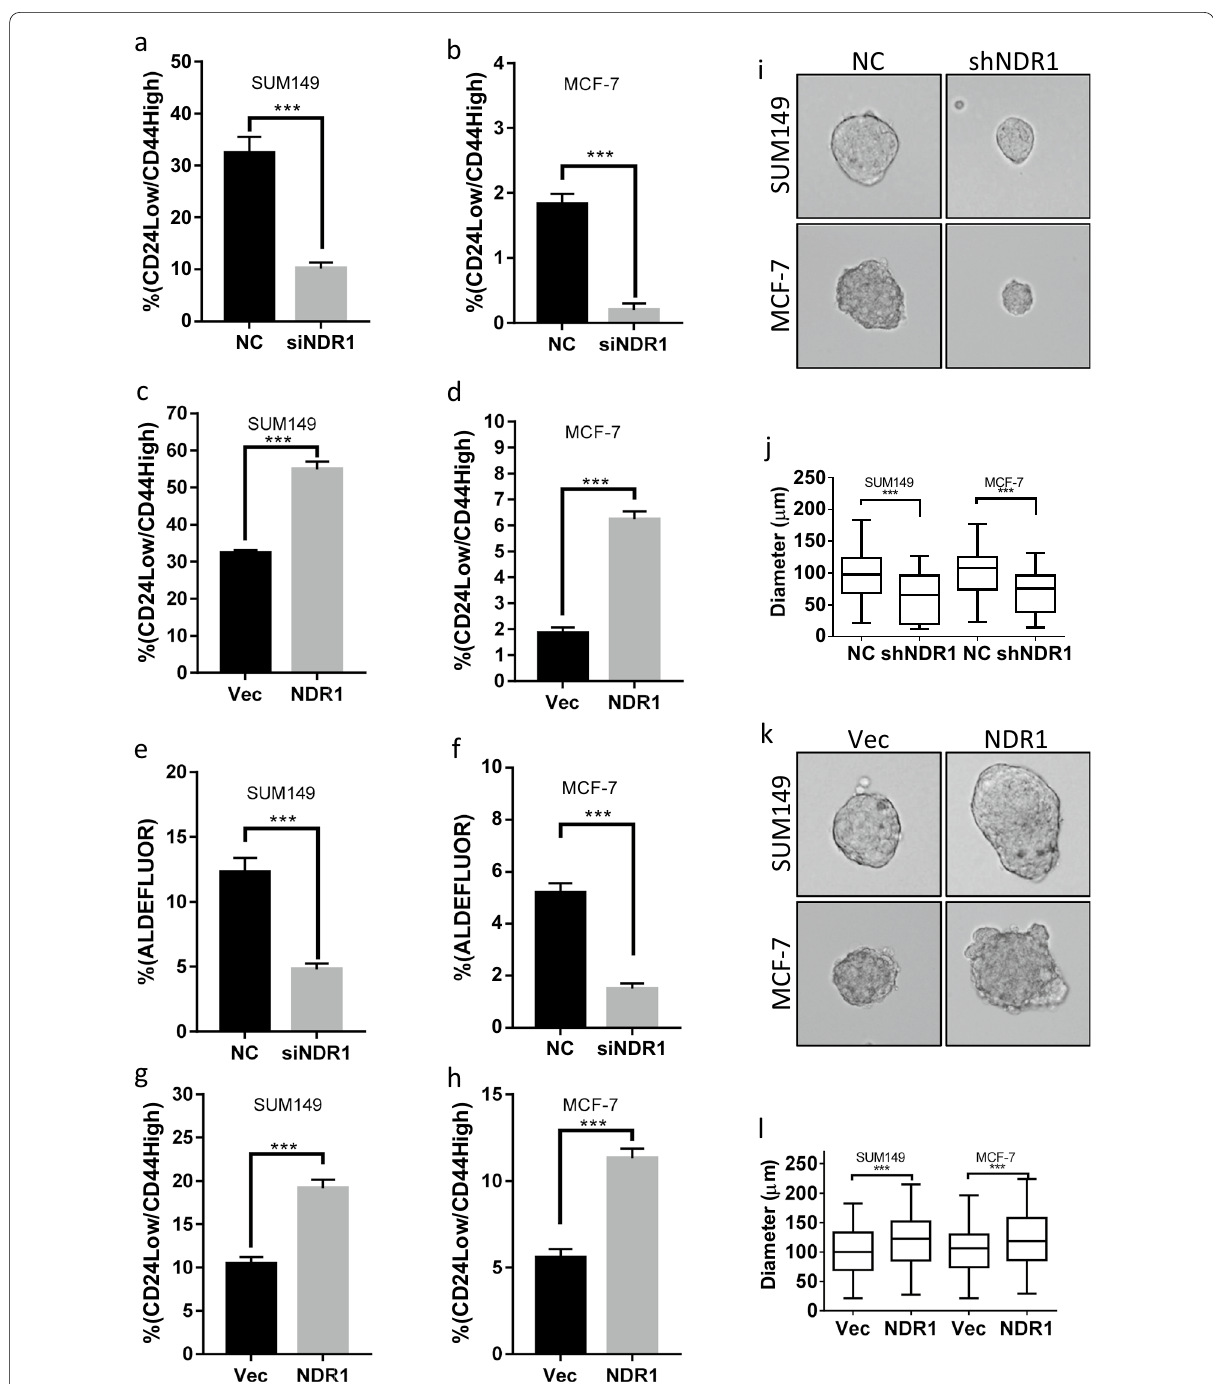
Fig. 2 NDR1 is critical for the regulation of cancer stem cell properties in breast cancer cells. a , b NDR1 siRNA or control siRNA were transfected in SUM149 or MCF‑7 cells for 72 h. Cells were harvested and subjected to CD24/44 staining and flow cytometry analysis. c , d NDR1 or control vector were expressed in SUM149 or MCF‑7 cells for 72 h. Cells were harvested and subjected to CD24/44 staining and flow cytometry analysis. e , f NDR1 siRNA or control siRNA were transfected in SUM149 or MCF‑7 cells for 72 h. Cells were harvested and subjected to ALDEFLUOR staining and flow cytometry analysis. g , h NDR1 or control vector were expressed in SUM149 or MCF‑7 cells for 72 h. Cells were harvested and subjected to ALDEFLUOR staining and flow cytometry analysis. i , j SUM149 or MCF‑7 cells expressed NDR1 shRNA or control vector were subjected to sphere‑forming assay. The representative spheres were shown in i . The distribution of sphere diameters was shown in j . k , l SUM149 or MCF‑7 cells expressed NDR1 or control vector were subjected to sphere‑forming assay. The representative spheres were shown in k. The distribution of sphere diameters was shown in l. The bar represents mean SD of three independent experiments (*: p < 0.05, **: p < 0.01, ***: p < ±